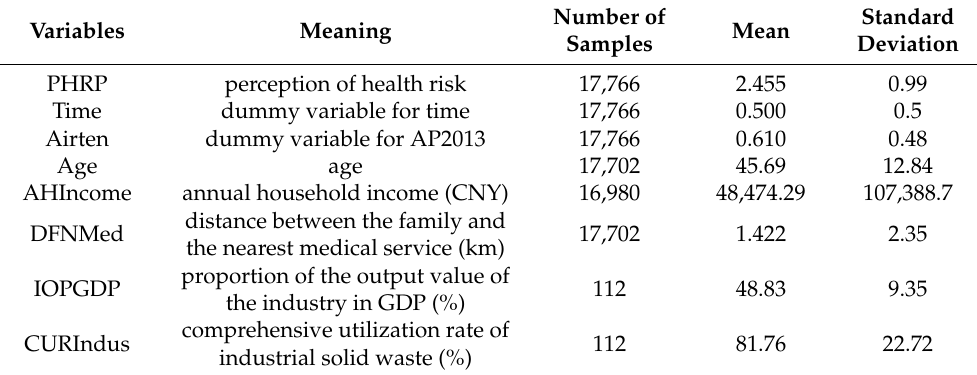
Table 2. Descriptive statistical analysis of variables.